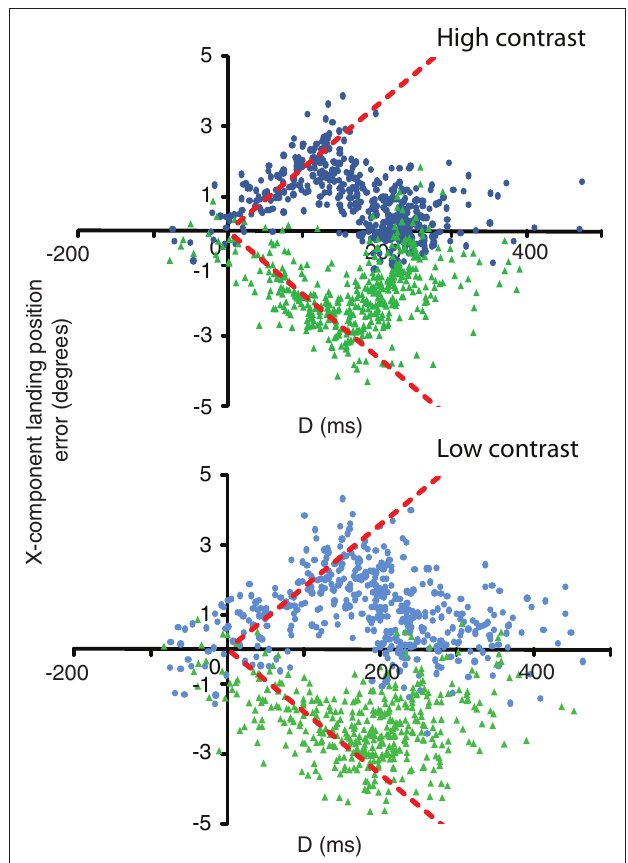
Figure 3 | D (time between velocity change and saccade onset) versus the x -component error in saccade landing positions for a single observer (observer 1). Data are separated out by contrast condition. Green triangles denote speed step up trials; blue circles denote speed step down trials. Predicted behavior based solely on the post-step speed corresponds to zero-error (i.e., the x -axis). Predicted behavior based solely on the pre-step speed is shown by the red